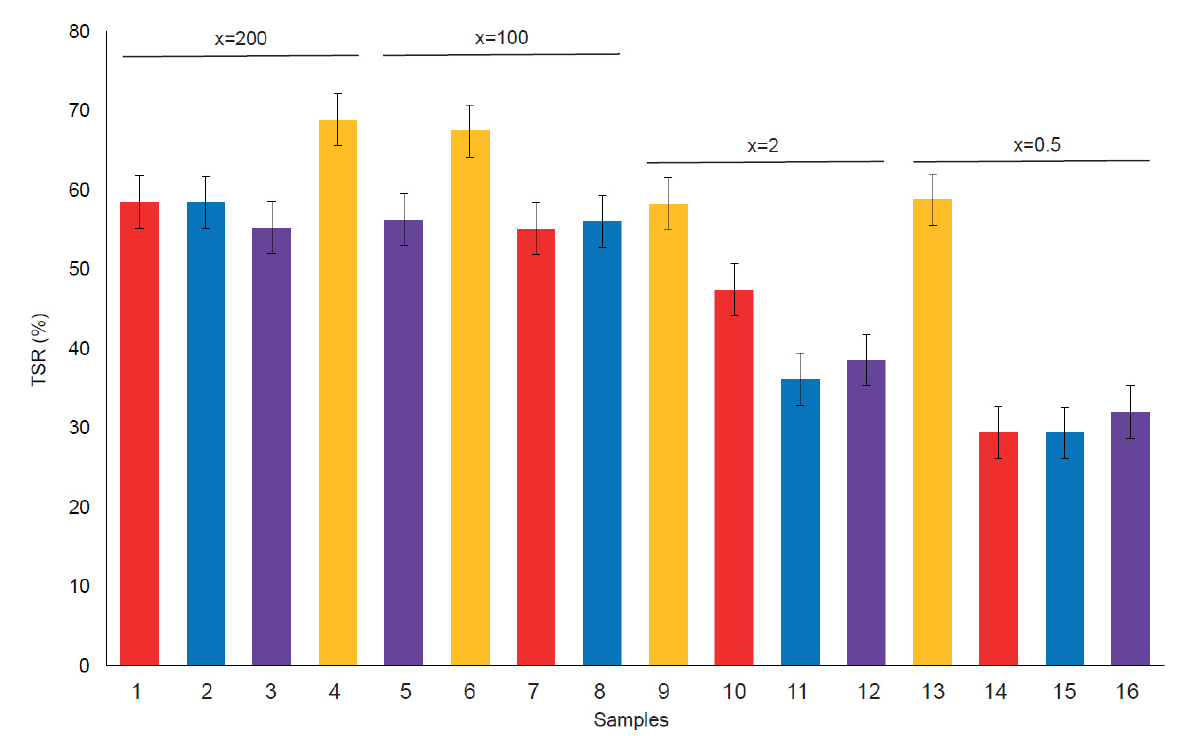
Figure 5. Total Solar Reflectance (TSR (%)) for each sample.